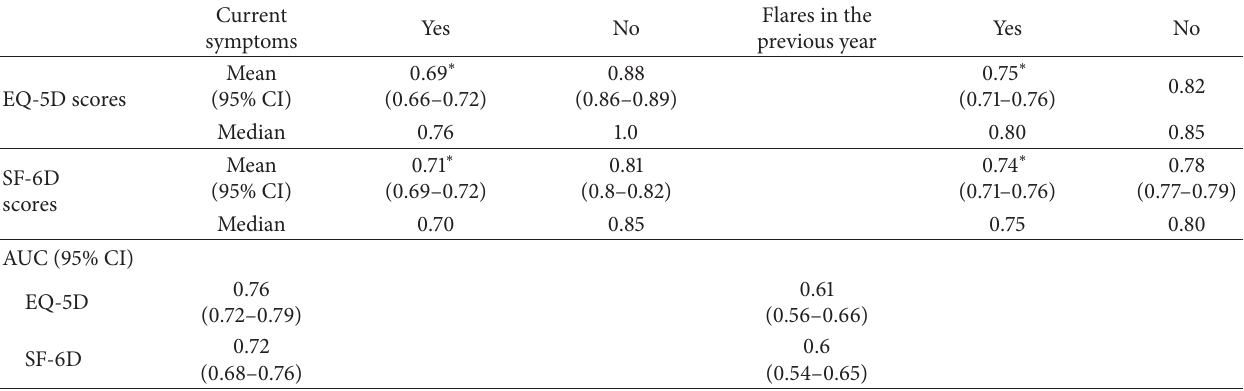
Table 4: EQ-5D and SF-6D index scores and subjectively perceived disease activities.